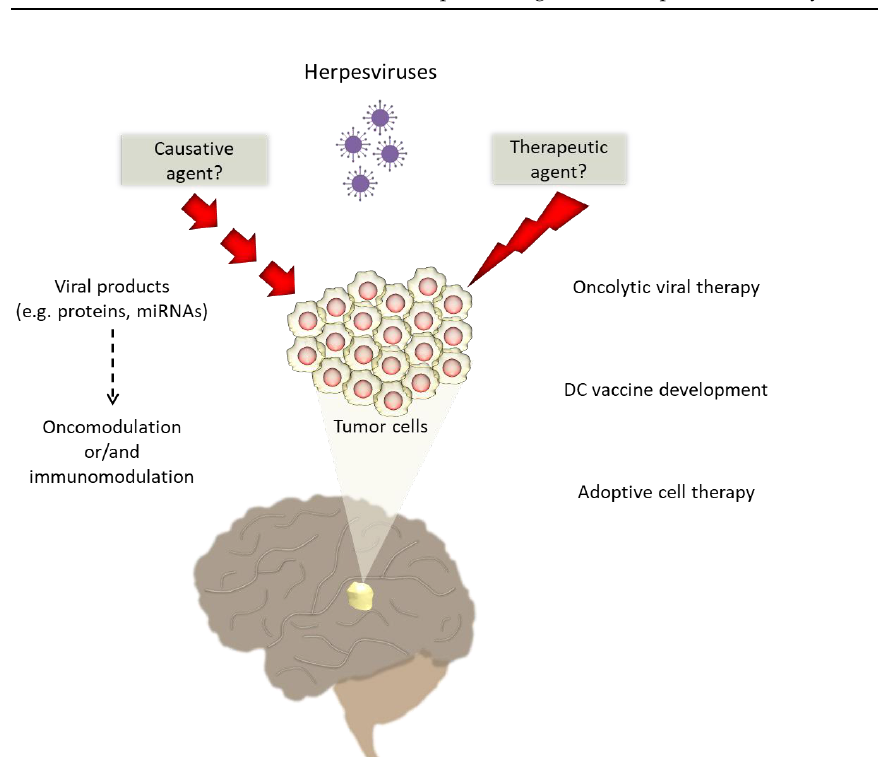
Figure 1. The interplay between herpesviruses and malignant brain tumors. The oncogenic, oncomodulating, or/and immunomodulating role of neurotropic herpesviruses in brain tumor development has been hotly debated and has not yet been proven. However, their neurotropic nature has formed the basis for the development of novel immunotherapeutic